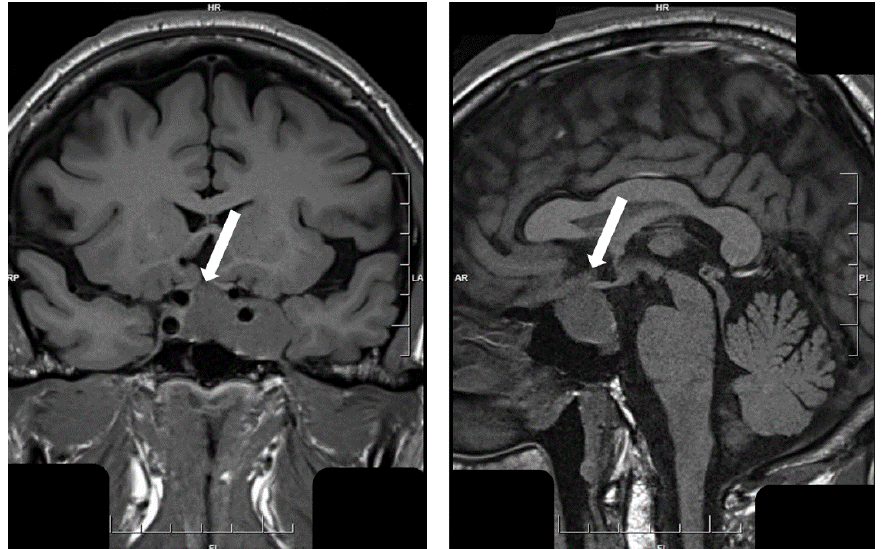
Figure 13. Magnetic resonance imaging of hypothalamic gangliocytoma with sparsely granulated somatotroph tumor. This tumor fills the sella turcica and the left cavernous sinus but also shows a thin attachment to the hypothalamus (white arrows).